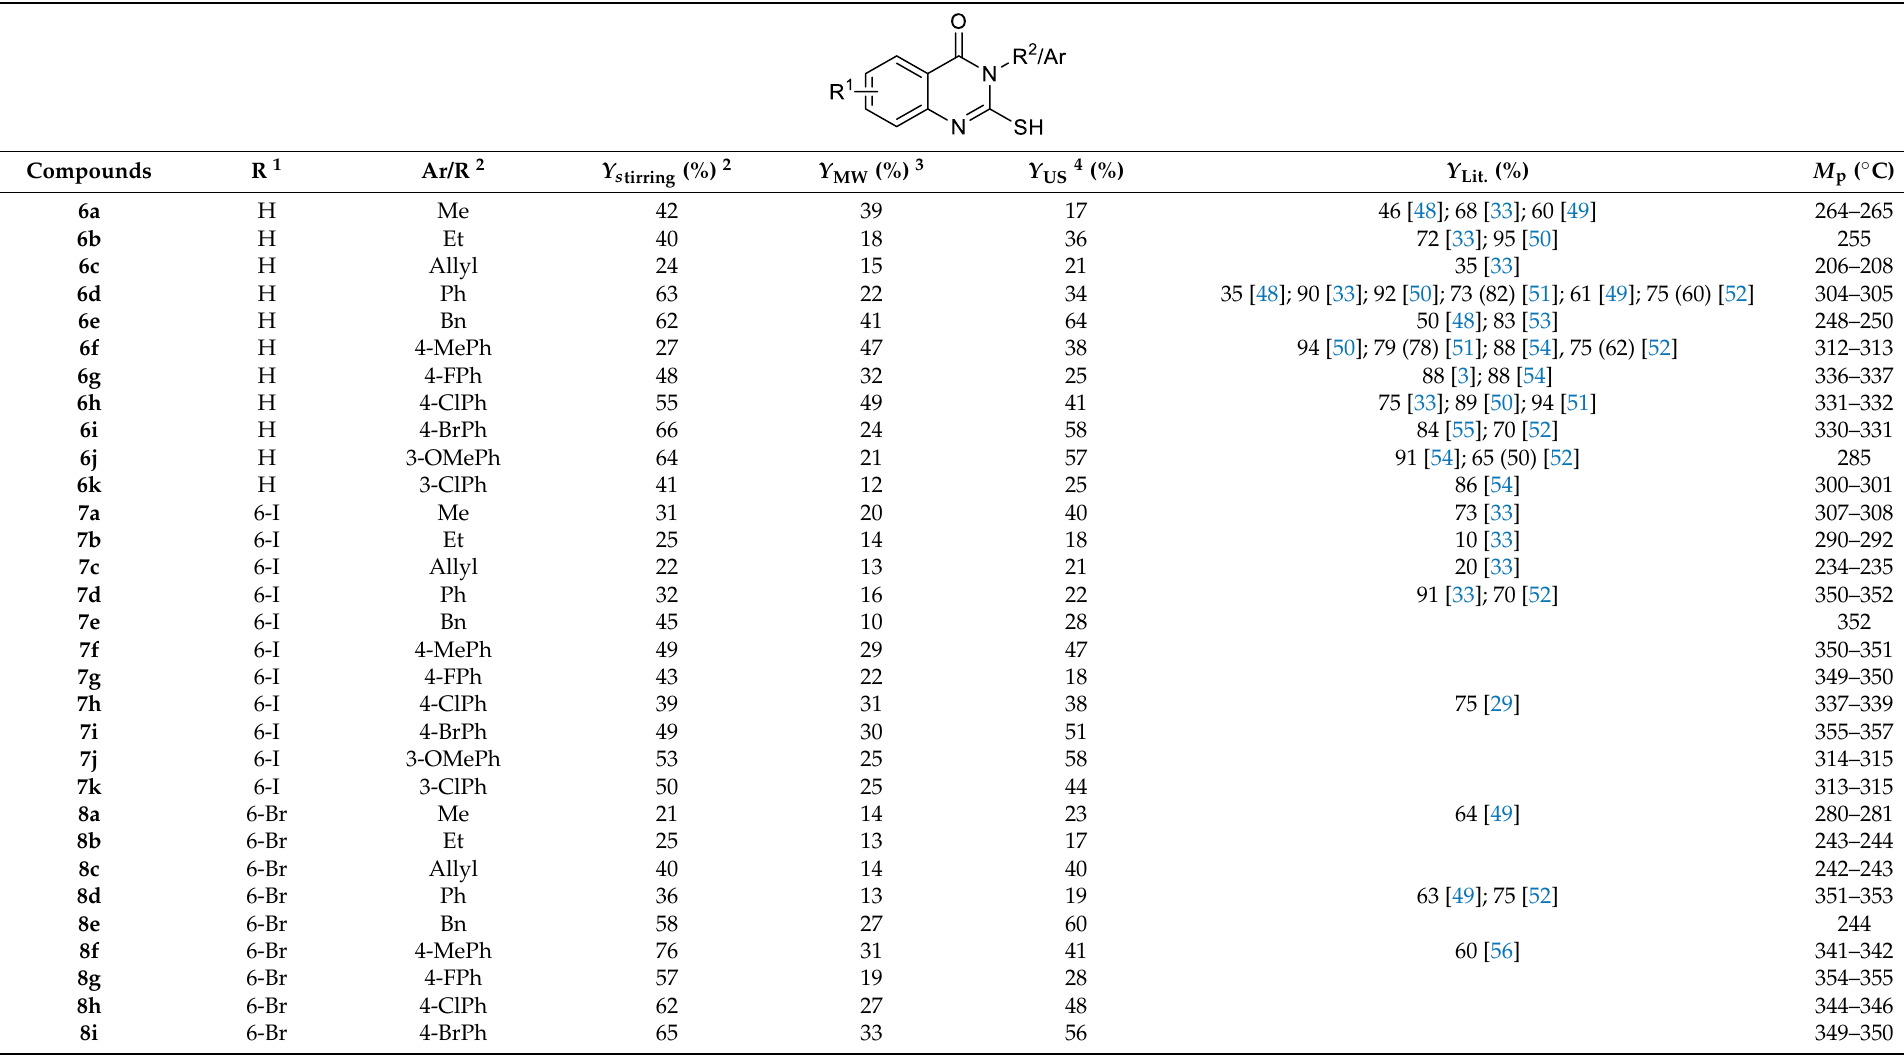
Table 2. A comparison of the substituted 2-mercaptoquinazolin-4(3 H )-ones yields 1 obtained with selected green methods with literature yields.